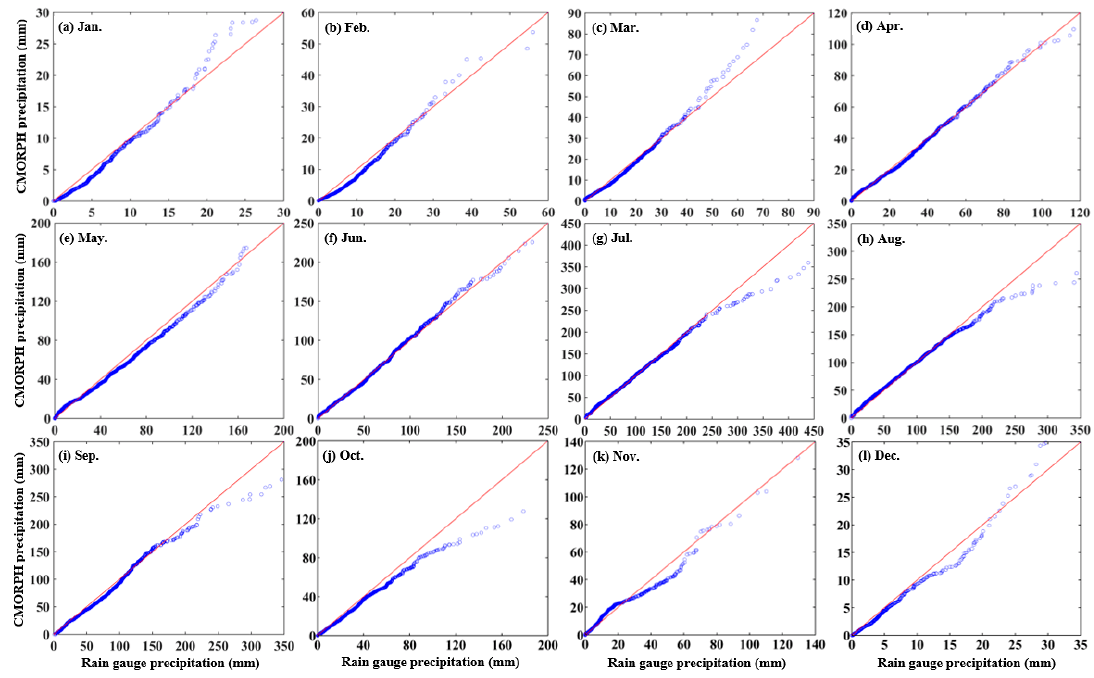
Figure 2. Quantile–Quantile (Q–Q) plots for the monthly Climate Prediction Center morphing technique (CMORPH) versus rain gauge precipitation in the Yellow River basin (YRB). ( a – l ) denote January, February, March, April, May, June, July, August, September, October, November, and December, respectively.